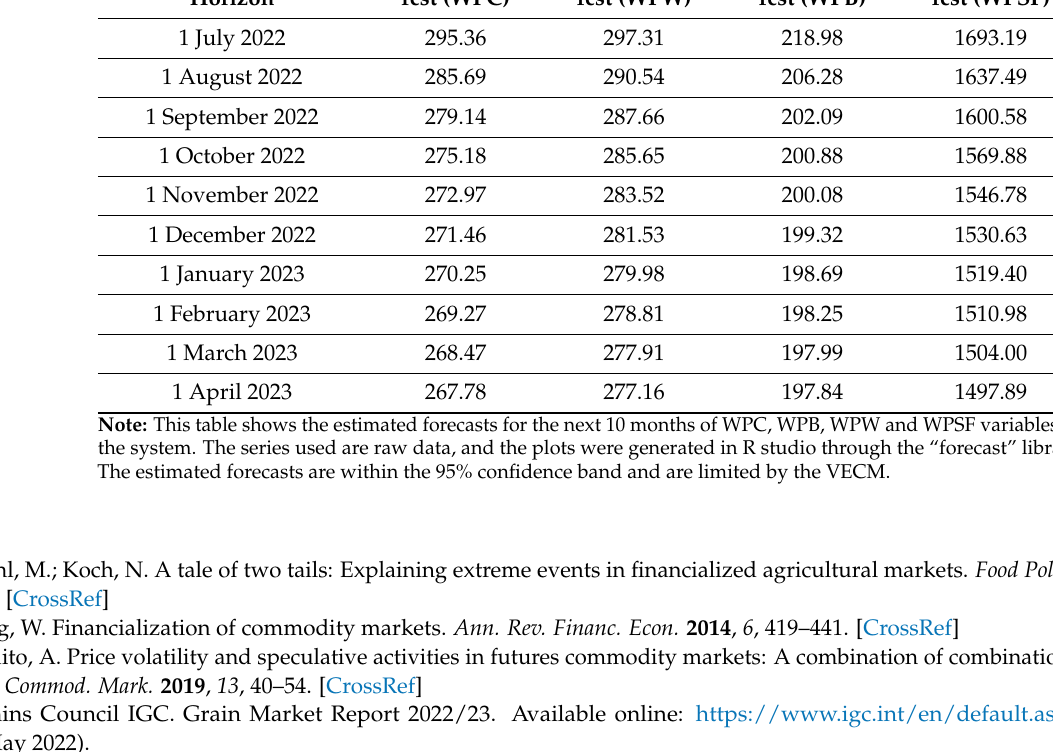
Table A2. Estimated predictions through the VECM fanchart for the four variables in our system.